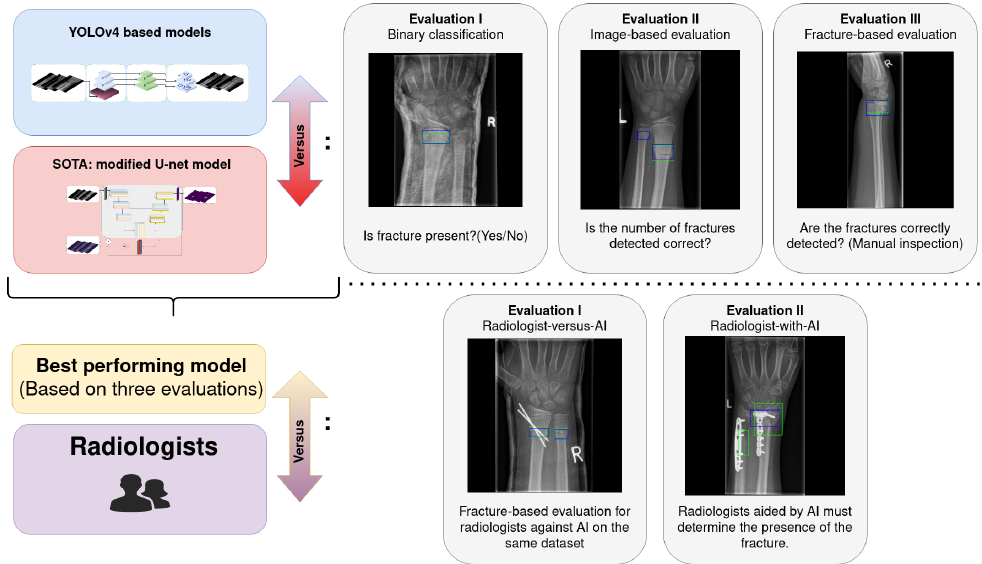
Figure 4. An illustration of the model evaluation